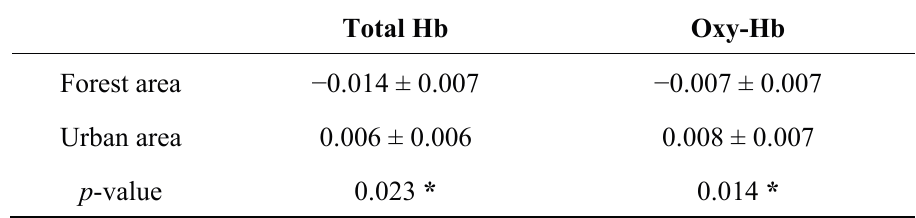
Figure 3. Comparison of the oxy-Hb concentration of subjects viewing forest and urban areas. N = 7, mean ± SE, * p < 0.05, determined by paired t -test. Table 1. Summary of the comparison of hemoglobin concentration between the forest and urban